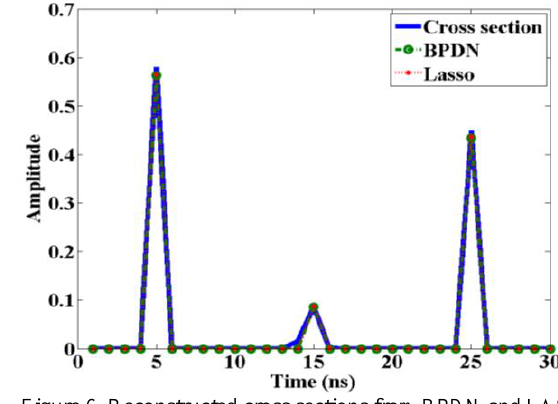
Figure 6. Reconstructed cross sections from BPDN and LASSO for data sample